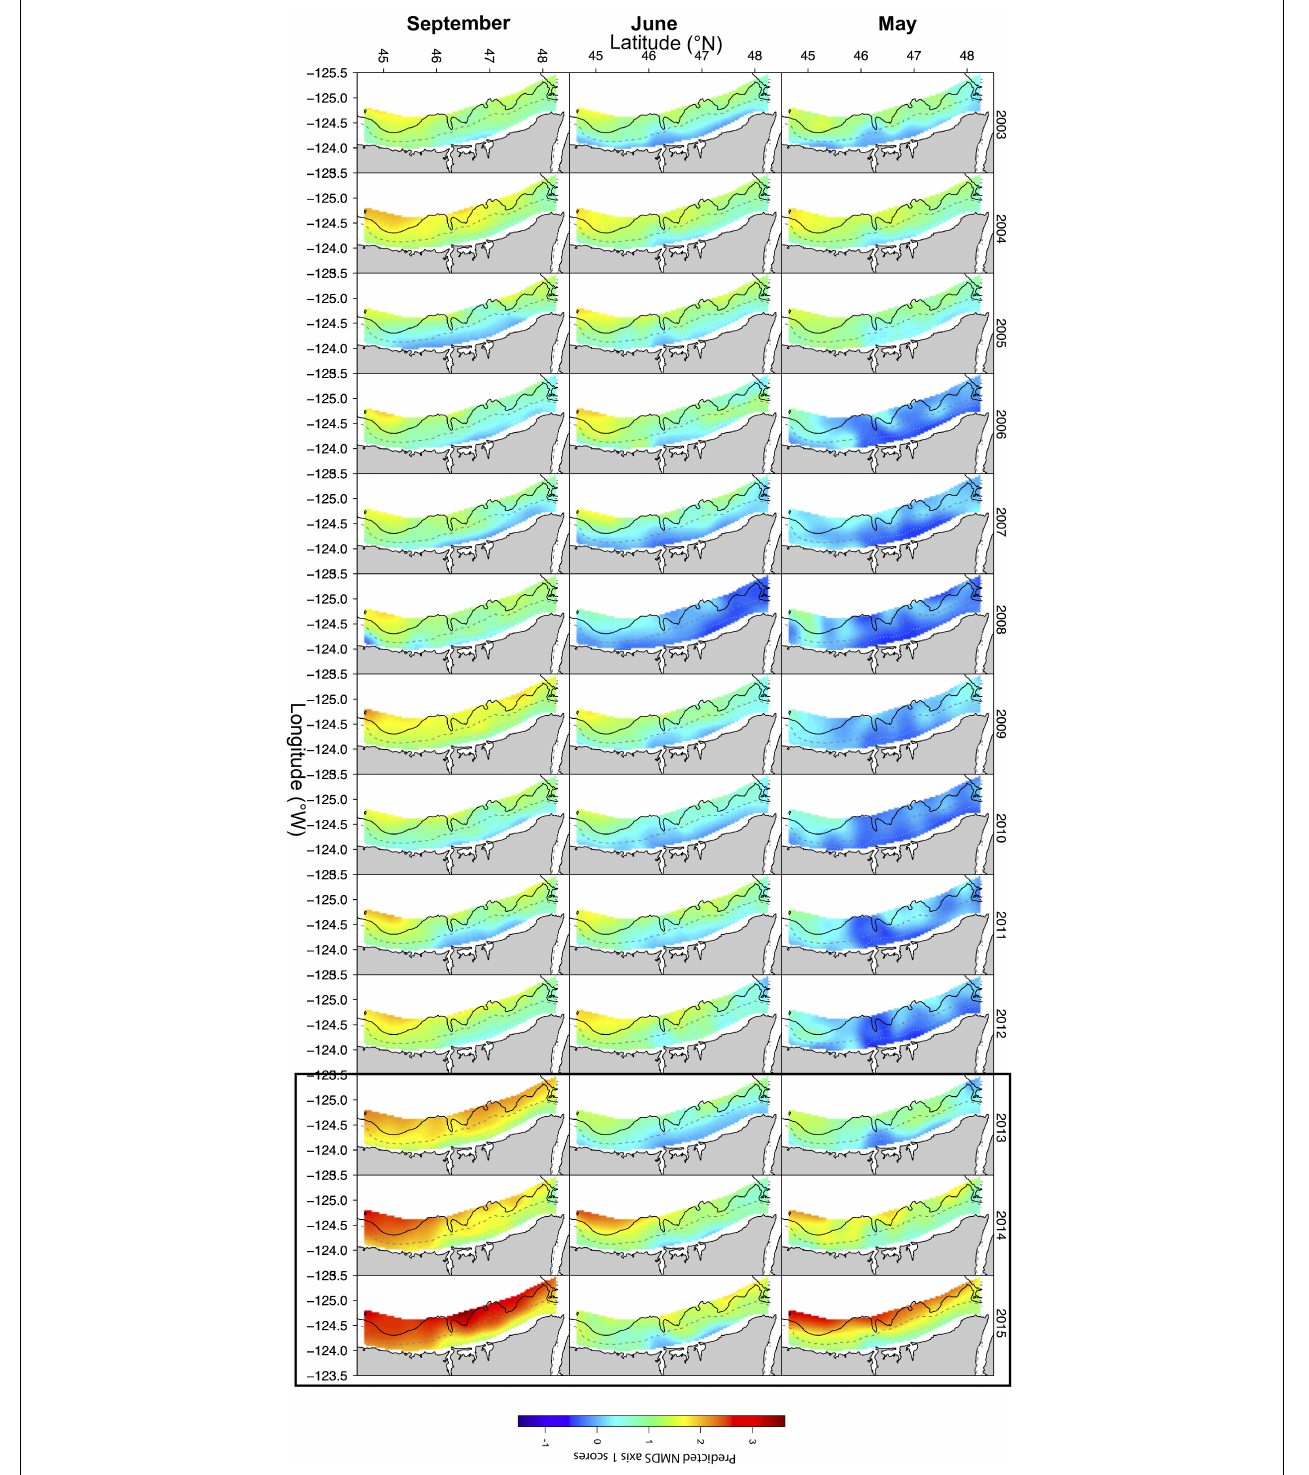
FIGURE 6 | Spatial predictions of NMDS axis 1 (representing the warm to cold-onshore community composition gradient) onto statistically (GAMM) combined remotely sensed MODIS data products in May (top row), June (middle row) and September (bottom row) between 2003 and 2012. May, June and September months of years 2013–2015 are predicted using prior data. Black box surrounding years 2013–2015 encompasses month/years where predictions were made outside of the range of the data included in the GAMMs.